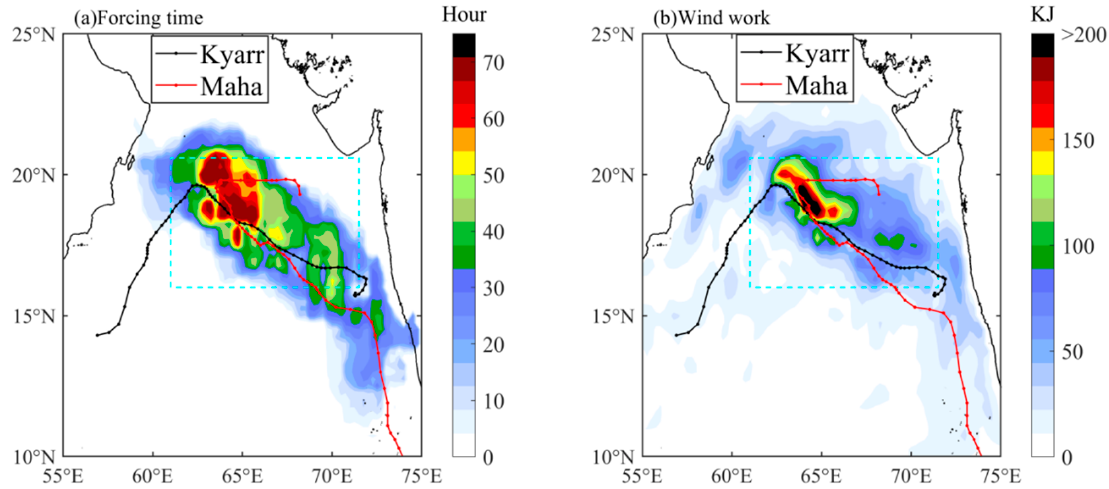
Figure 10. The spatial forcing time ( a ) and wind work ( b ) in the AS during the sequential TCs.